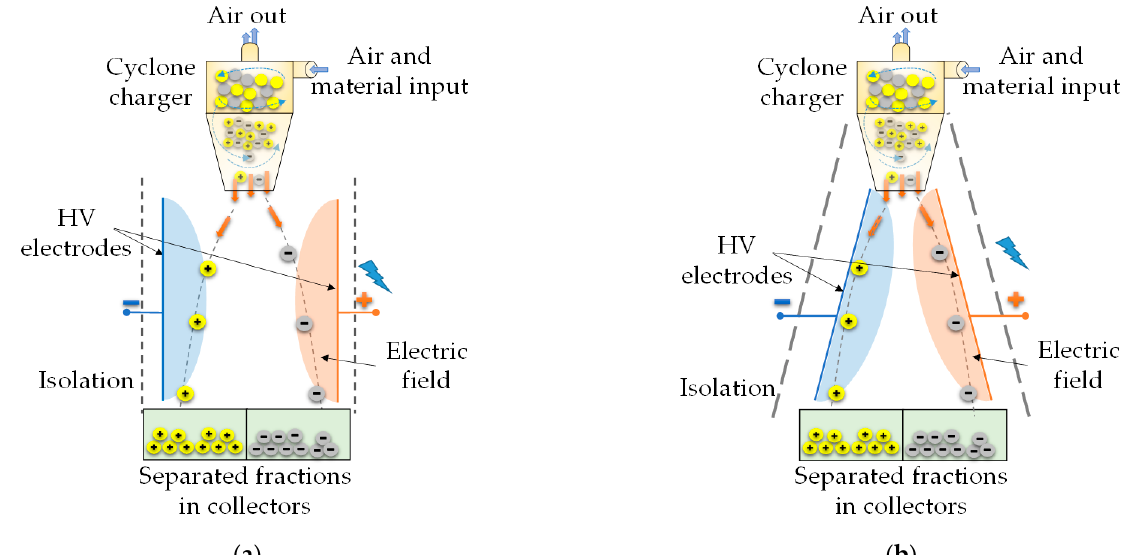
Energies 2021 , 14 , x FOR PEER REVIEW Figure 1. A free-fall triboelectrostatic separator ( a ) parallel plate, ( b ) skew plate.